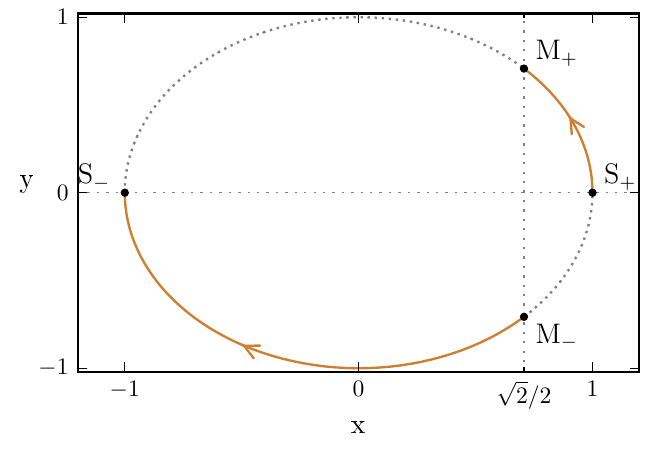
Figure 7. Case B: asymptotically dust contraction close to the unstable point M + , where w evolves smoothly from 0 to 1 without ever passing by a dark energy phase. After the quantum bounce, the system emerges from S , and follows a dark energy phase until reaches the future dust attractor M + −